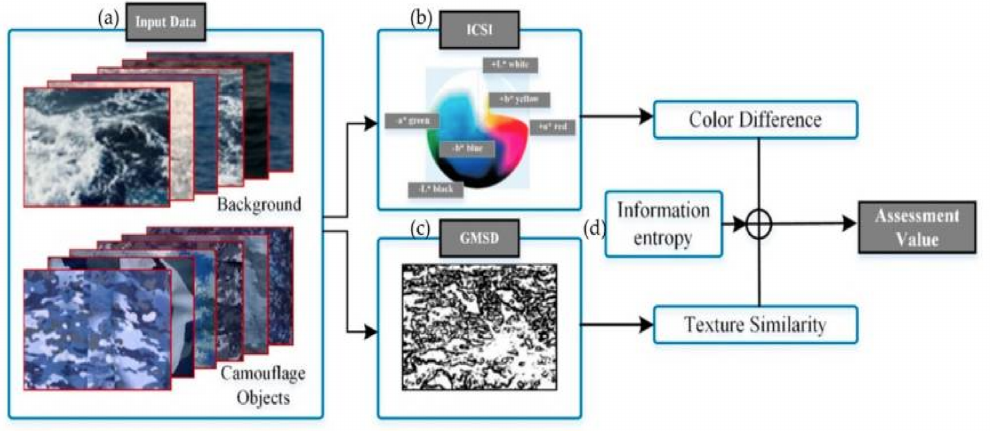
Figure 17. Method of estimating the camouflage quality